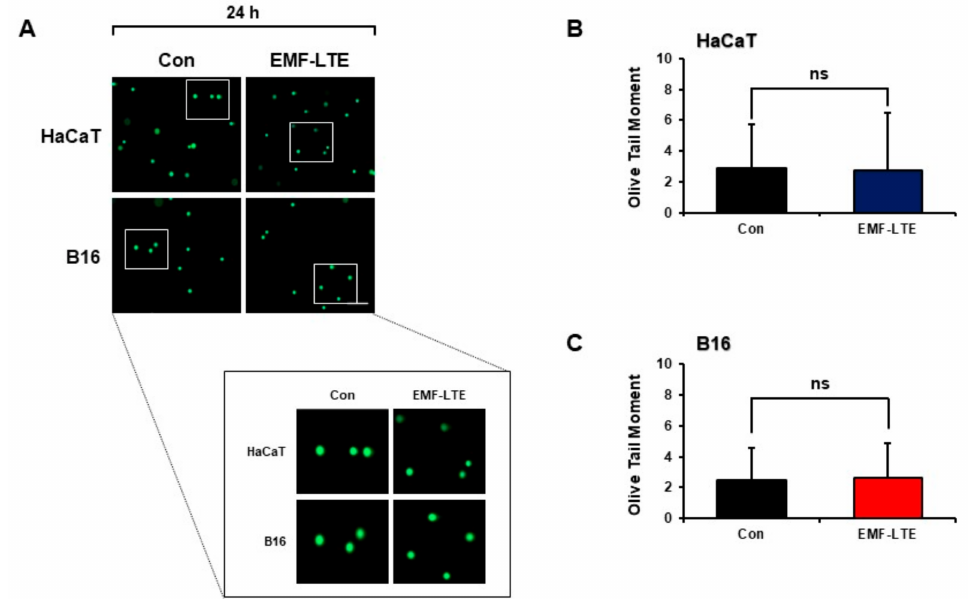
Figure 2. Effects of EMF-LTE on DNA DSB damage in HaCaT and B16 cells. ( A ) HaCaT and B16 cells were irradiated with EMF-LTE for 24 h, and the neutral comet assay was performed. Representative photos are presented. ( B ) ( C ) The olive tail moment was calculated using Comet 5.5 software. The scale bar indicates 50 µ m (magnification: 5 × ). The data represent the mean ± SD. ns: not significant by paired sample t -test ( n =